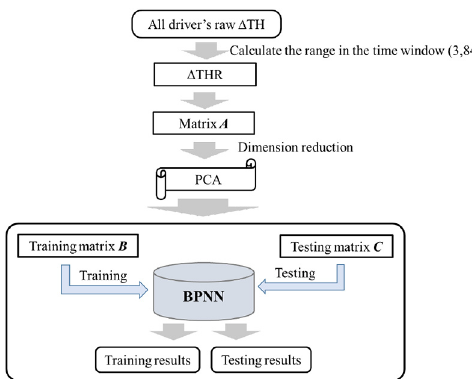
Figure 8 The establishment process of the driver ’ s braking intention identi fi cation model